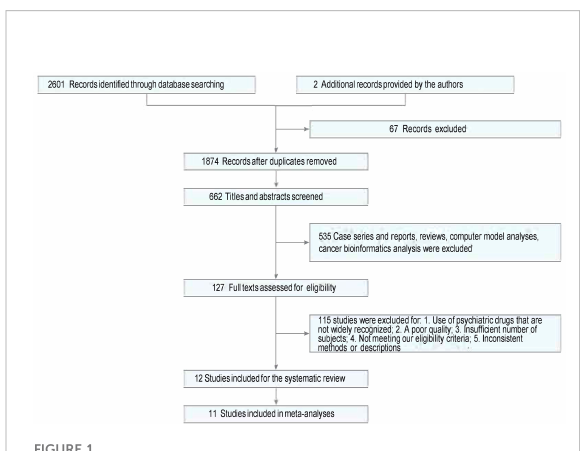
FIGURE 1 PRISMA fl ow diagram summarizing the article selection